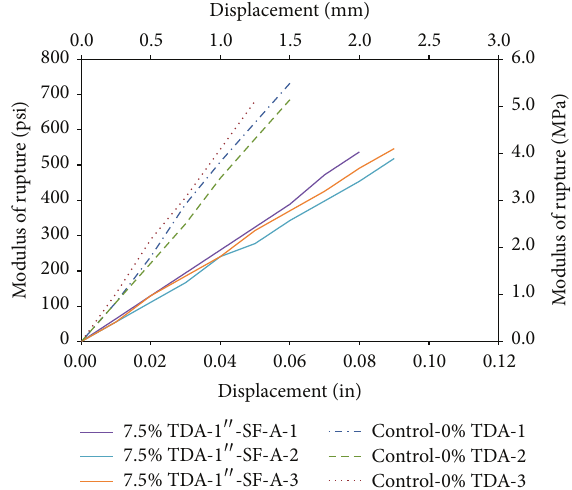
Figure 10: Comparison of modulus of rupture between the control concrete (Control-0% TDA) and TDA concrete with silica fume (7.5% TDA-1 󸀠󸀠 -SF-A).